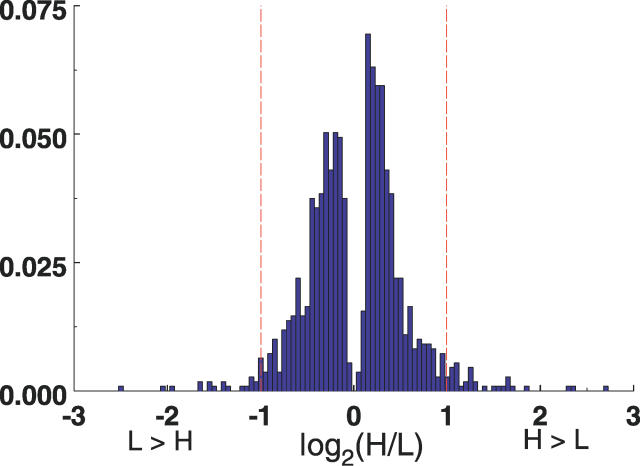
Histogram Showing Frequency of Relative Fold-Change in Probe Sets with Significant Differences in Transcript Abundance between H and L Selection Lines, Pooled over SexesThe vertical red lines demarcate 2-fold changes in transcript abundance.